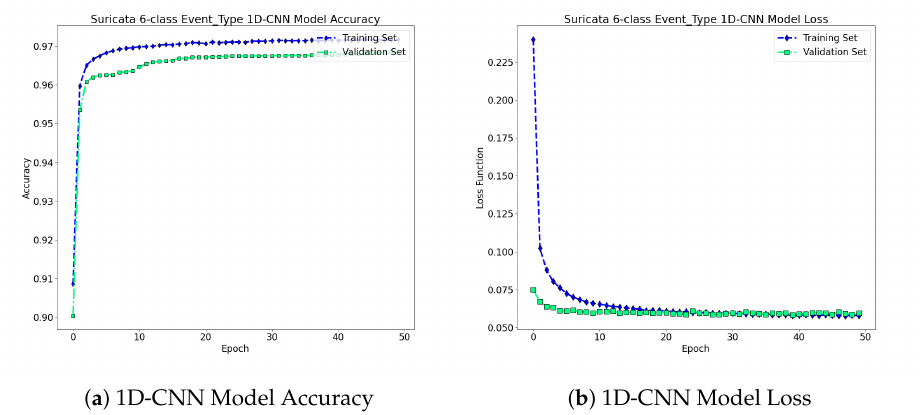
Figure 8. Multiclass 1D-CNN Classification Accuracy and Model Loss Functions: As we may notice, both the classification accuracy and the loss functions during the training/testing phases depict proper convergence rates after a few number of epochs without presenting high variation among their accuracy/loss function scores.